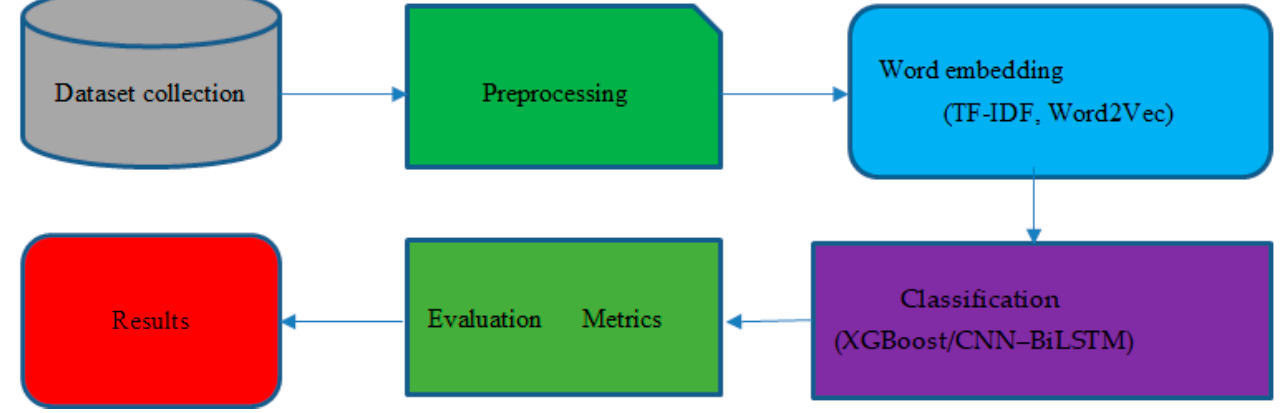
Figure 1. Framework of the proposed suicide ideation detection system.